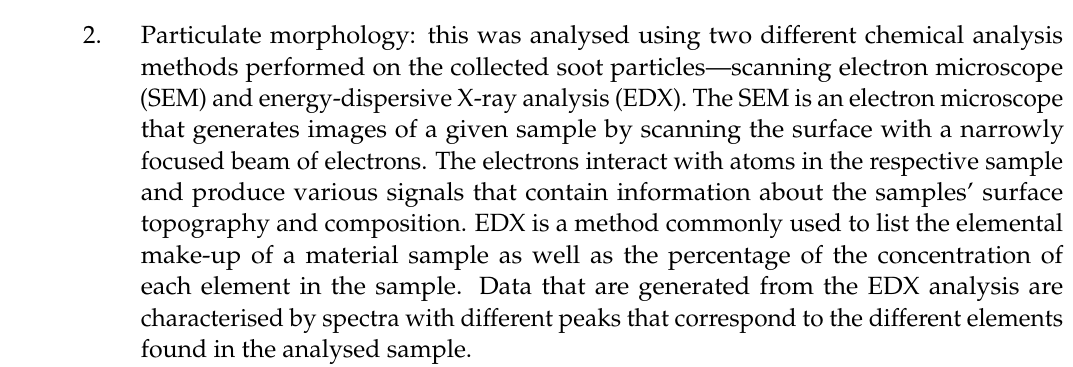
Figure 4. Figure 4a corresponds to the measurement in Figure 3. The contour plots are three-dimensional maps that show the particulate diameter on the Y-axis, the time on the X-axis, and the PN concentration on the